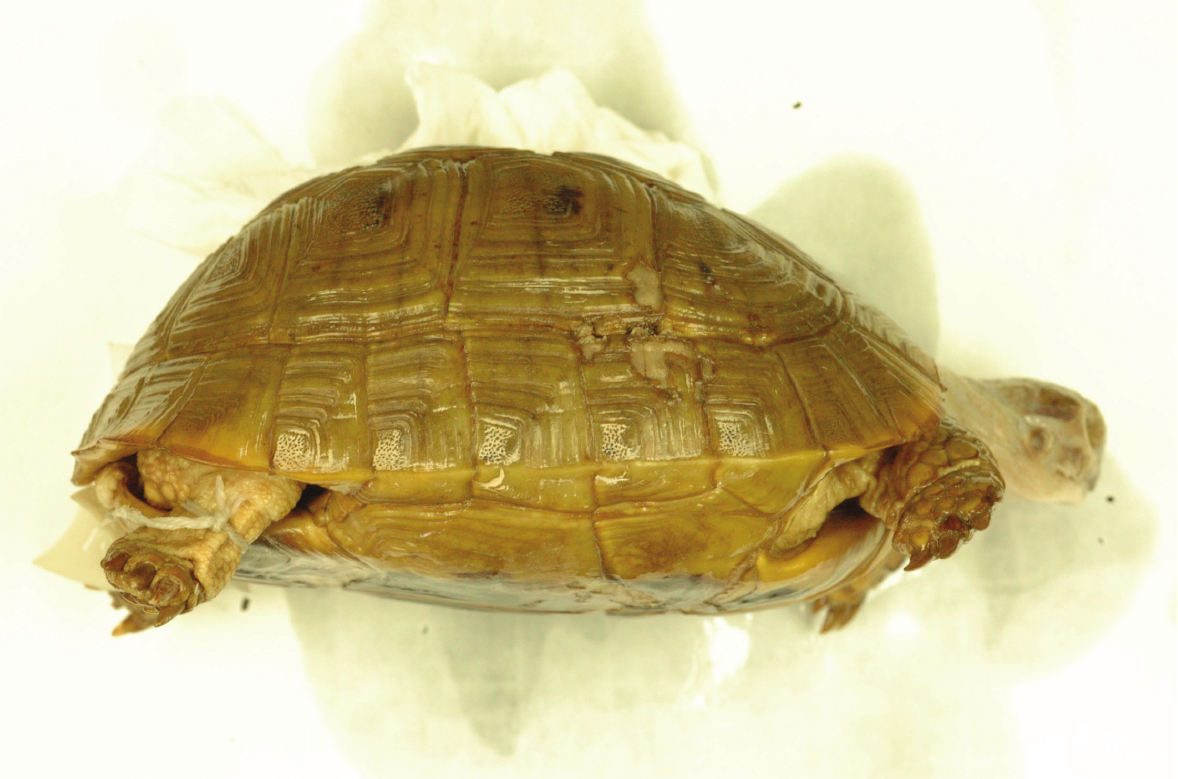
Figure 3. MNHN 0.1937., designated Neotypus of Testudo graeca mauritanica , lateral. (Photograph: A.